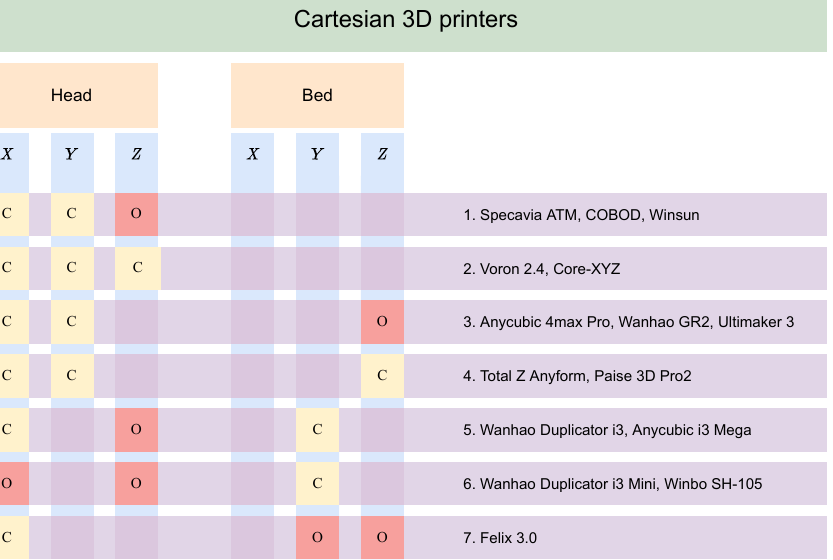
Figure A11. Classification scheme for existing Cartesian 3D printer designs, yellow C stands for closed axis, red O stands for open